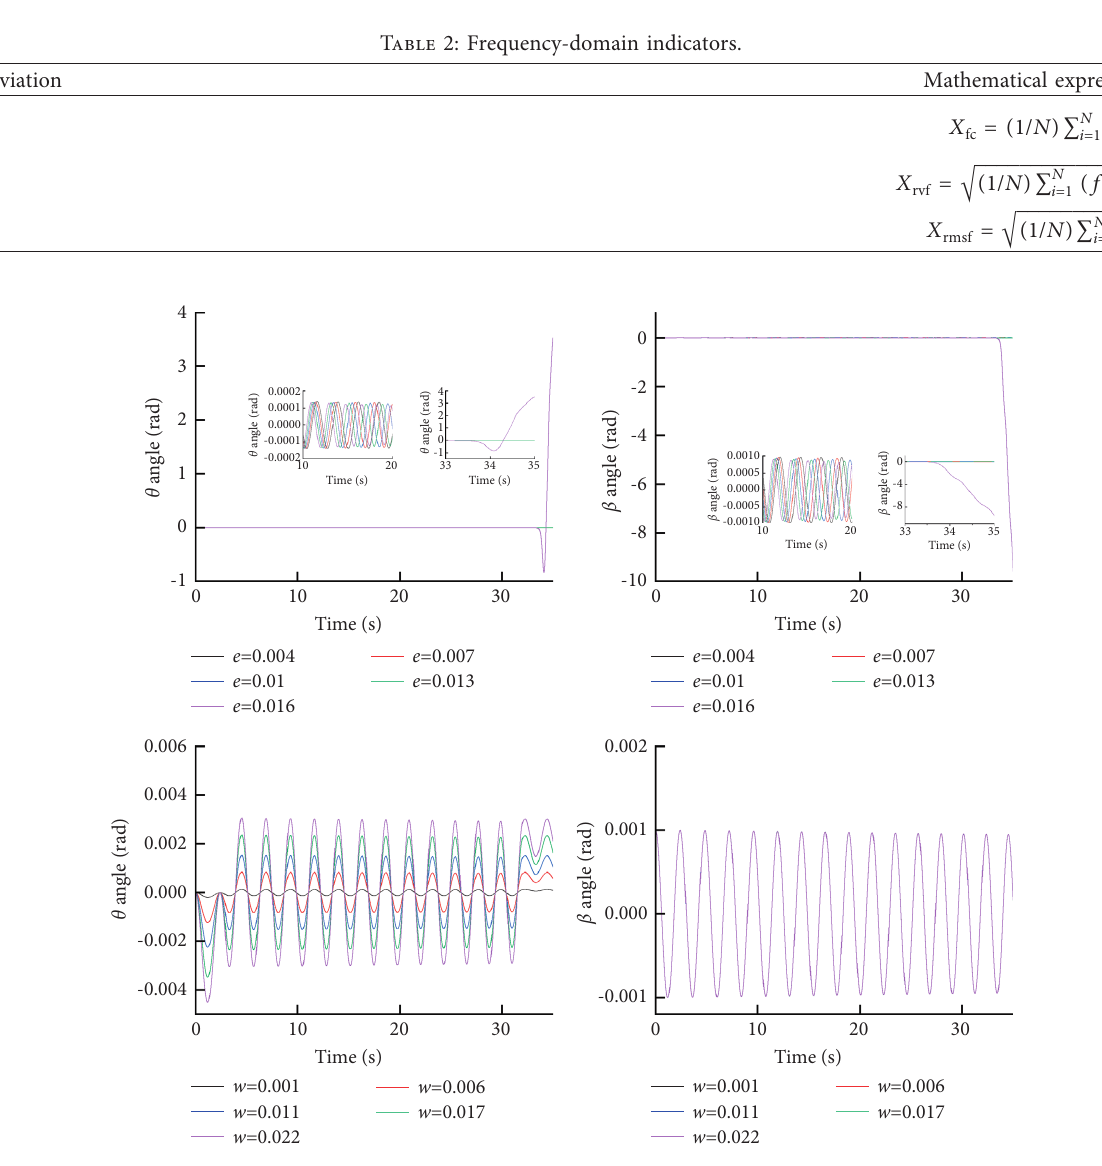
Figure 6: Response of e and w to the